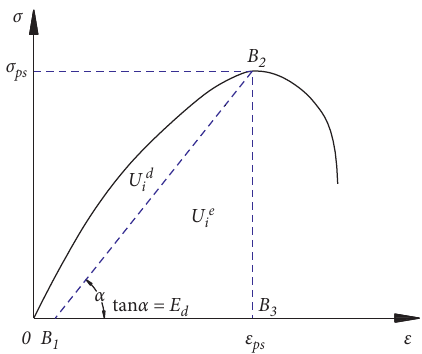
Figure 7: Calculation diagram of elastic energy density and plastic energy density under the common action of high static stress unloading and impact